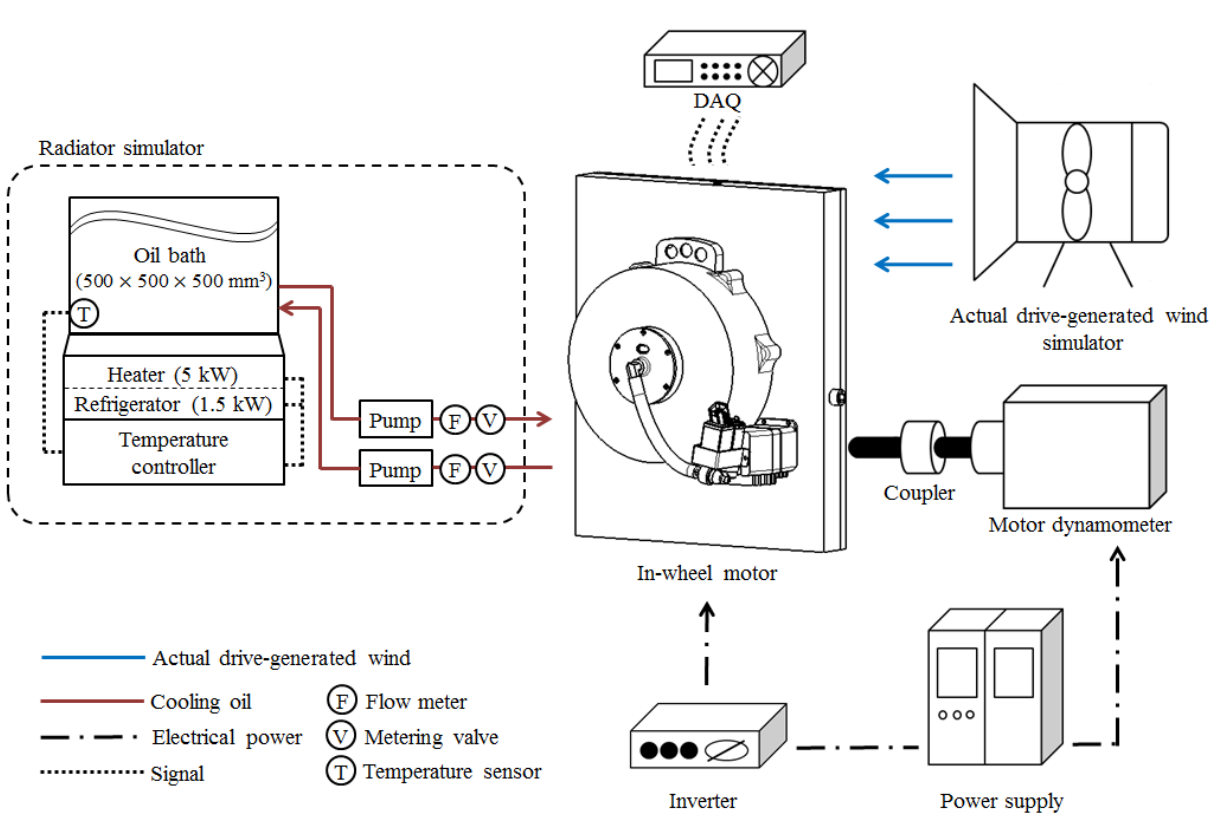
Figure 3. Experimental setup for evaluating thermal